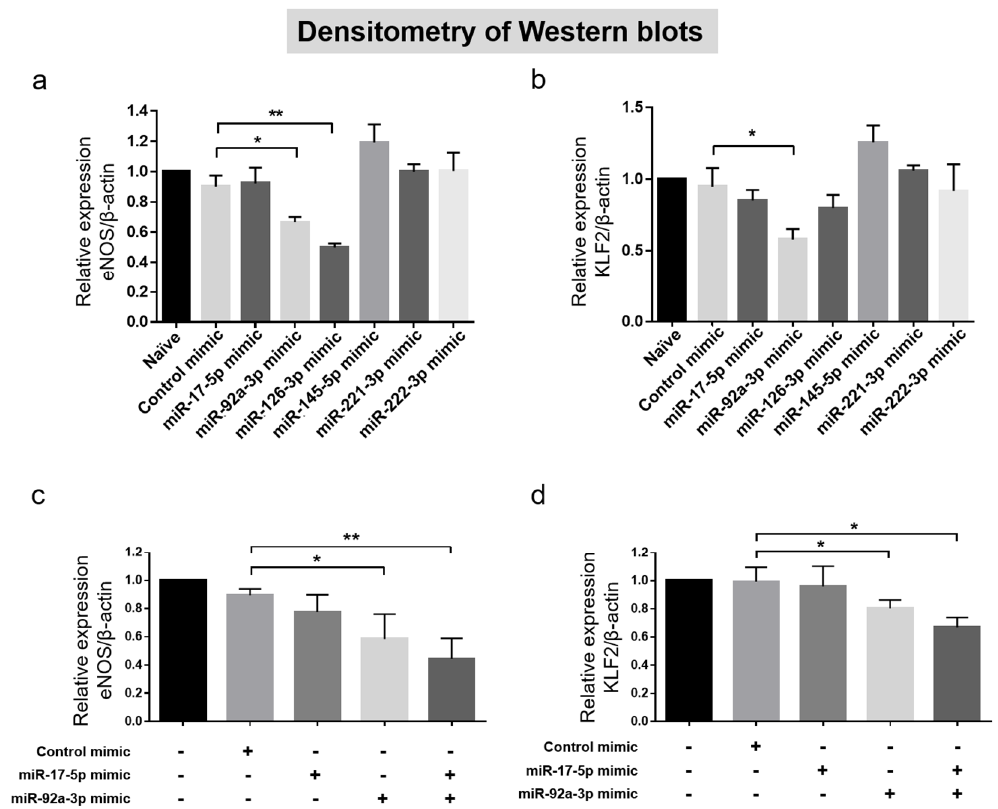
Figure 4. The role of miRs in endothelial eNOS protein expression. Densitometry of eNOS after each pre-miR transfection ( n = 3) ( A ), densitometry of KLF2 after each pre-miR transfection ( n = 3) ( B ), and densitometry of eNOS and KLF2 after pre-miR-17-5p and pre-miR-92a-3p co-transfection ( n = 3) ( C , D ). One-way analysis of variance was applied and data are presented as mean ± standard deviation. * indicates p < 0.05, ** indicates p < 0.01, *** indicates p < 0.001. eNOS: Endothelial nitric oxide synthase; miR, microRNA.